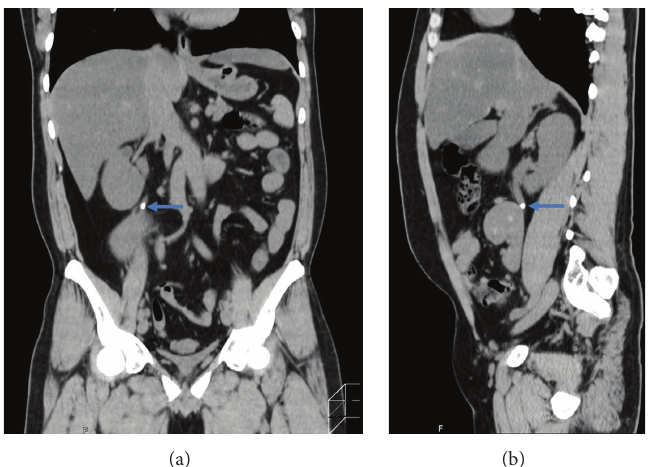
Figure 1: Coronal (a) and sagittal (b) sections of unenhanced computed tomography of the abdomen show left-to-right crossed unfused renal ectopia and a 5 mm stone (arrows) in the proximal ureter of the kidney located cranially. A left inferior vena cava is also seen.